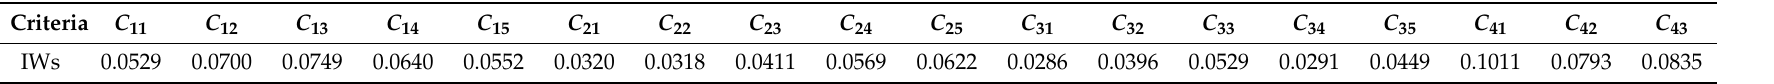
Table A7. The influential weights of DANP when lim z → ∞ ( W ) z